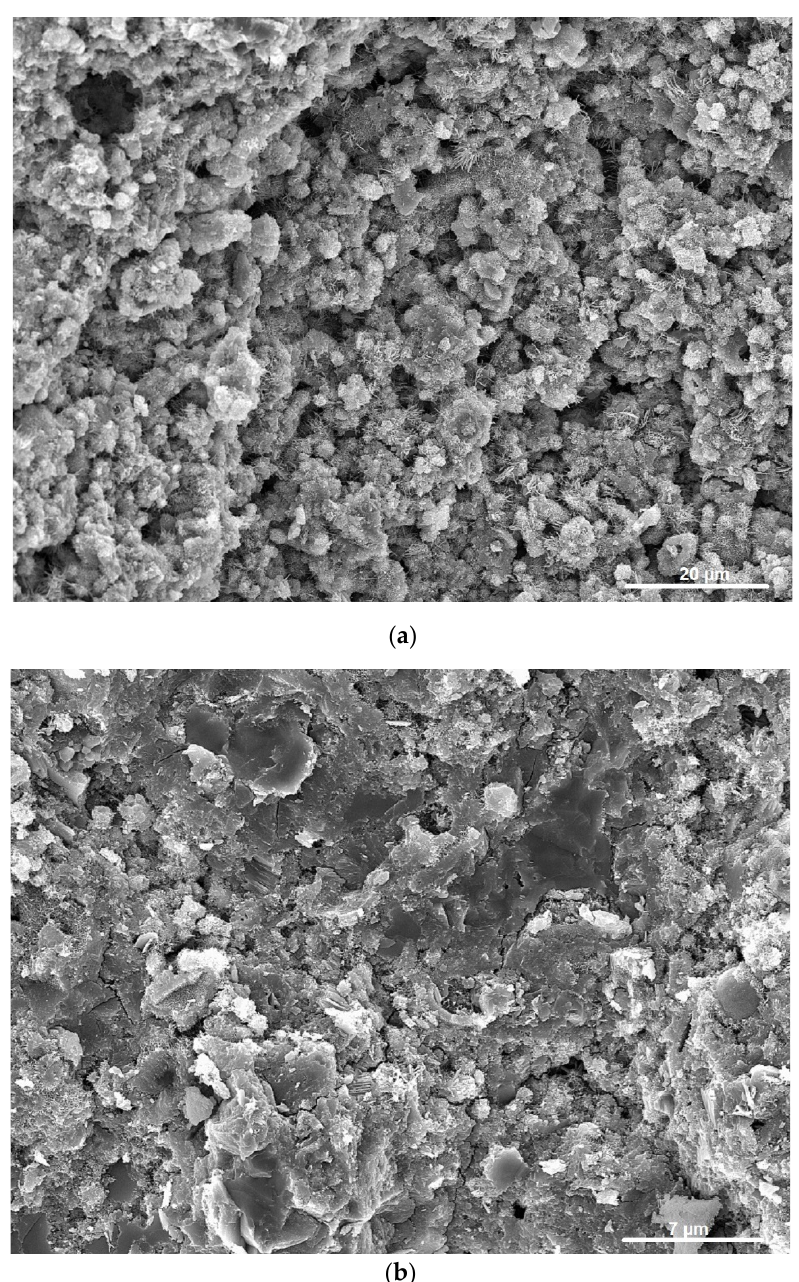
Figure 9. ( a ). Sample microstructure of cement slurry containing 3% n-Al 2 O 3 . Magnification 500 × . ( b ). Sample microstructure of cement slurry containing 3% n-Al 2 O 3 . Magnification 1300 × .